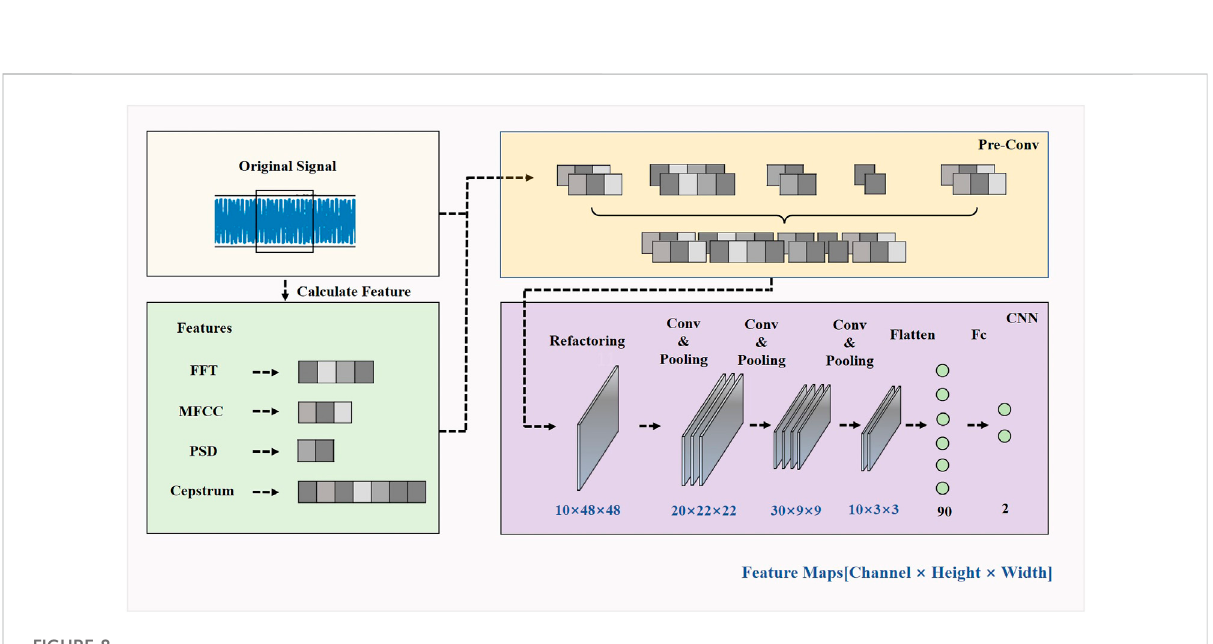
FIGURE 8 CNN with